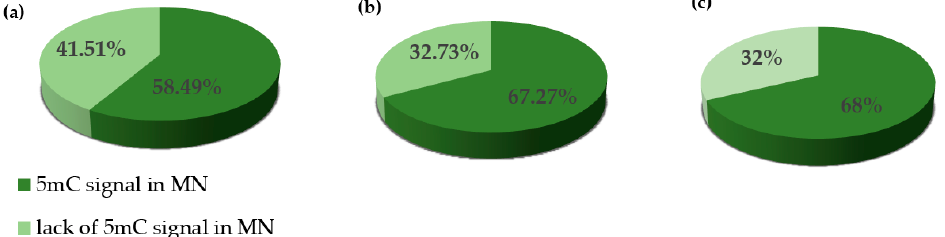
Figure 3. The frequencies of micronuclei (MN) with and without 5 mC signals after MH treatment at different posttreatment times: ( a ) 0 h, ( b ) 10 h, ( c ) 20 h.